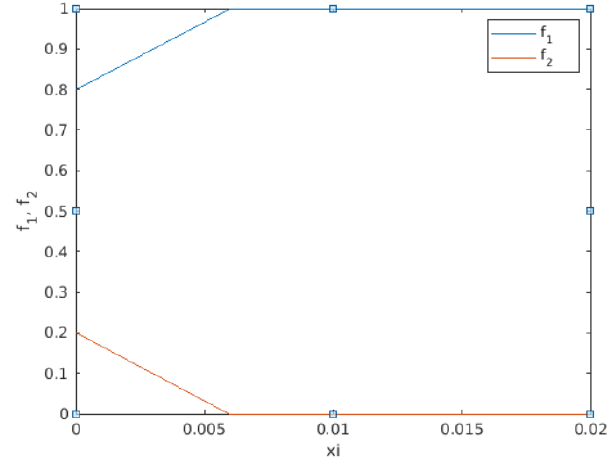
Figure 8. Travelling wave solutions. The blue solution represents the evolution of the nitrogen within the tank evolving from 0.8 (80% in volume) up to filling the whole tank 1 (100%). The red solution represents the oxygen density that evolves from 0.2 (20% in volume) down to zero. Note that the horizontal axis represents the variable ξ , while ϕ 1 = f 1 = N and ϕ 2 = f 2 = Θ